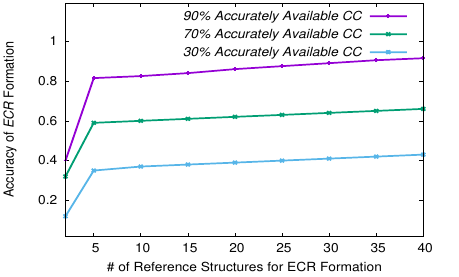
Figure 10. Accuracy of ECR Corresponding to the number of Reference Structures of CC Combinations